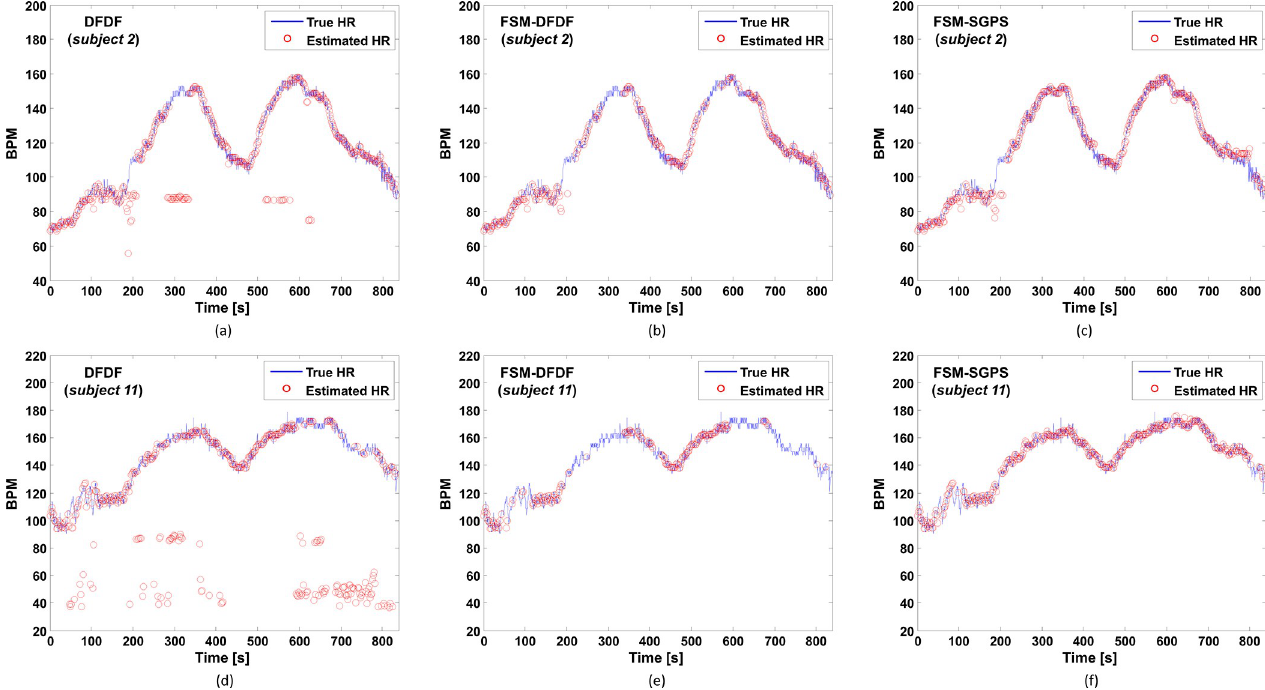
Fig 7. Estimated HR trace comparison for two subjects of the ISPC dataset, obtained by DFDF (with MA cancellation only), FSM-DFDF (with MA cancellation and FSM framework), and FSM-SGPS (the proposed algorithm). (a) DFDF results of subject 2 , (b) FSM-DFDF results of subject 2 , (c) FSM-SGPS results of subject 2 , (d) DFDF results of subject 11 , (e) FSM-DFDF results of subject 11 , (f) FSM-SGPS results of subject 11 .